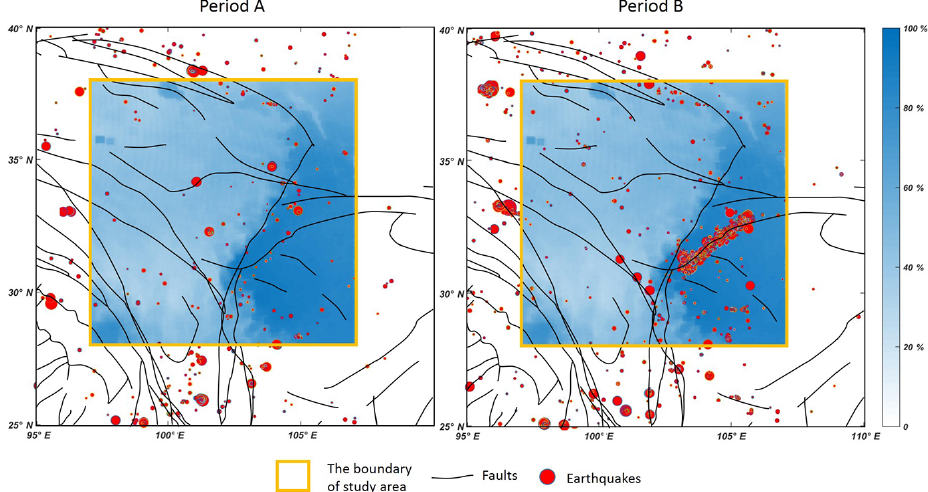
Figure 8. The distribution of earthquakes in periods A and B and the frequency of each pixel being blocked by cloud cover in period C; higher values indicate that the pixels are more frequently blocked by